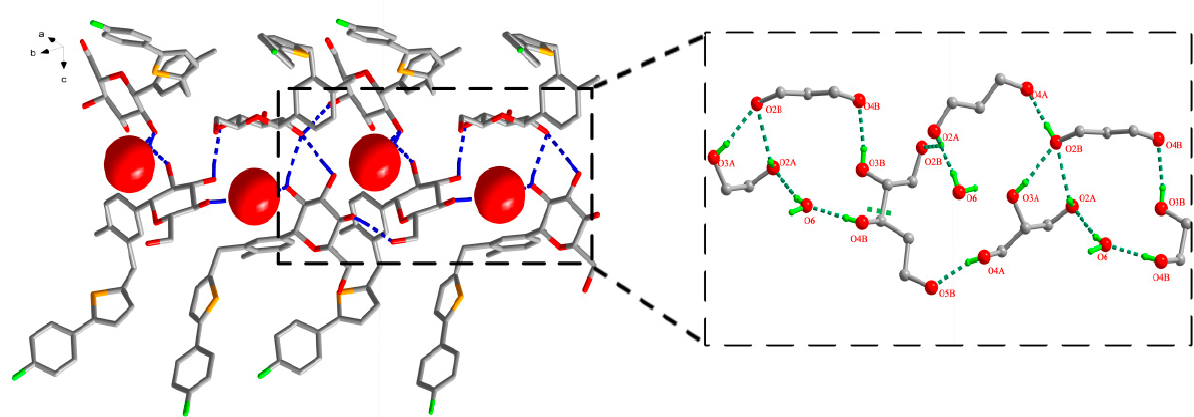
Figure 4. Water molecule and CG molecule interlinked by hydrogen bonds in the CG-Hemi crystal structure. There were three types of ring motifs along b axis, R 4 (15), R 1 (7) and R 4 (21). Hydrogen bonds were represented by dashed lines. For clarity, hydrogen atoms not involving in hydrogen bonds were omitted.